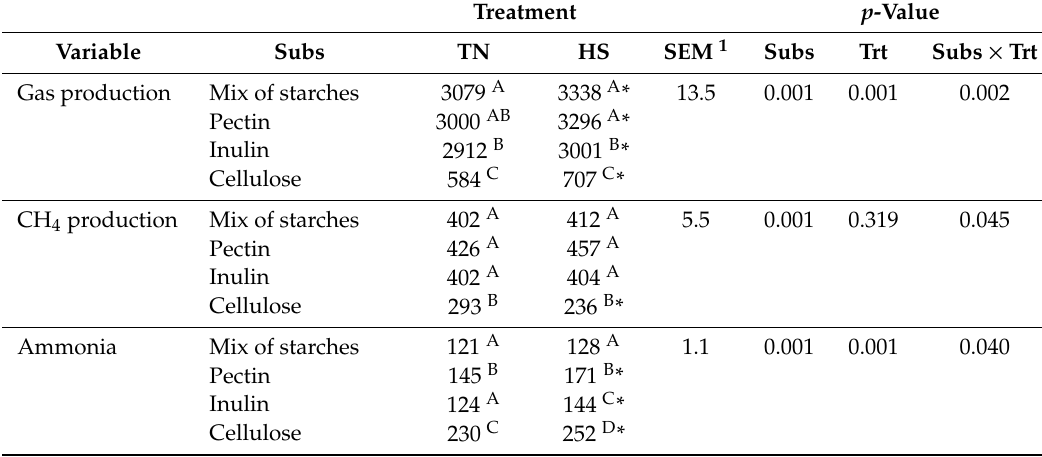
Table 4. Gas and methane (CH 4 ) production ( µ mol) and concentrations of ammonia (mg / L) after 24 h in vitro fermentation of four substrates (Subs) by fecal inocula obtained from pigs under thermoneutral (TN) or heat stress (HS)